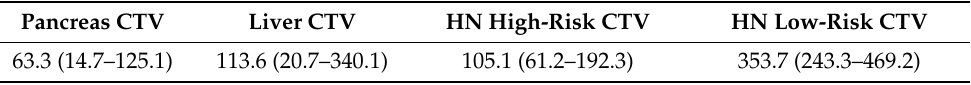
Table 1. Average (minimum and maximum) CTV volumes in cm 3 of all patients by